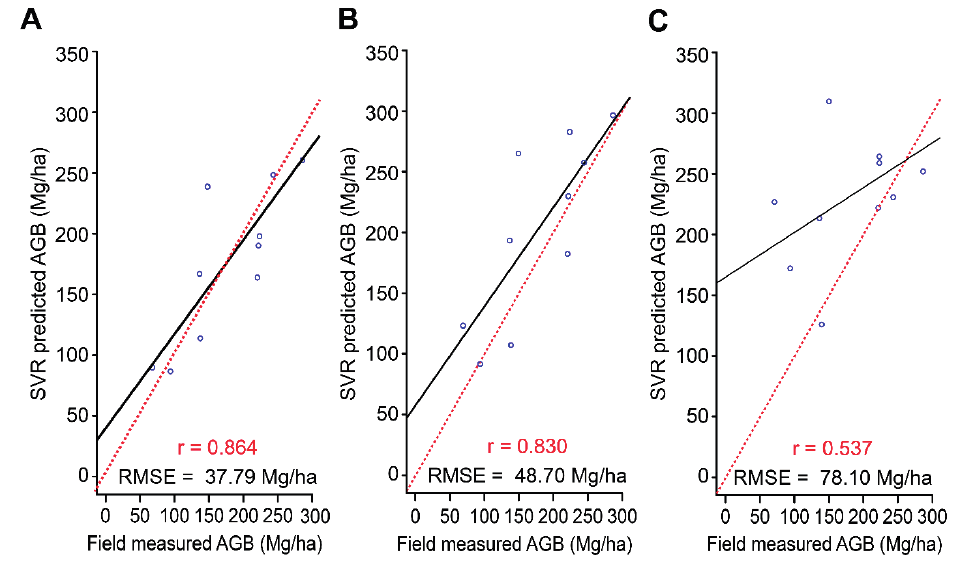
Figure 6. SVR-predicted AGB vs. field-measured AGB, as derived from VHR imagery via the Fourier-based textural ordination (FOTO) method using ( A ) HCV + VCH, ( B ) HCV only and ( C ) TV only. Solid black lines represent regression lines; red dashed lines represent 1:1 correspondence lines.